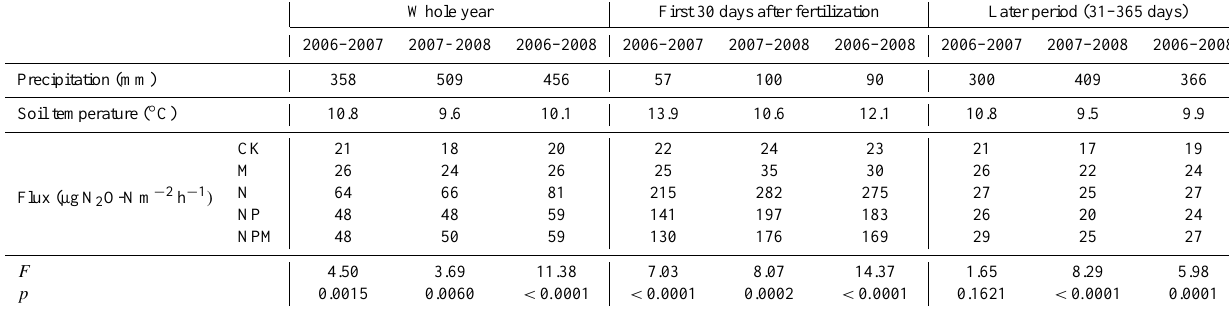
Table 2. Mean N 2 O fluxes during the first 30 days after fertilization and during the most of the year (the later period). Whole year First 30 days after fertilization